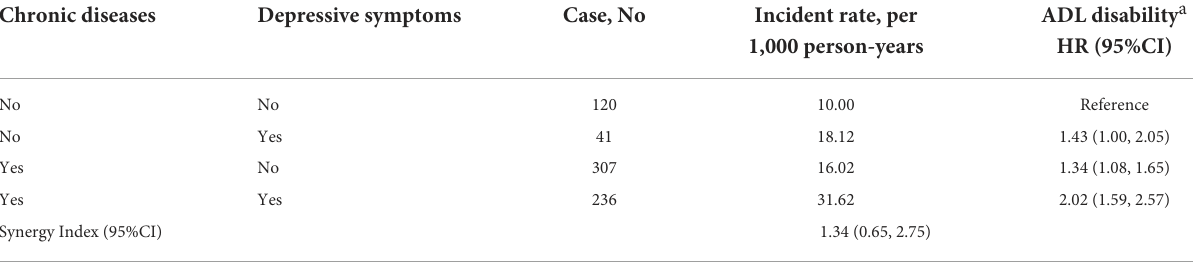
TABLE 3 The interaction between chronic diseases and depressive symptoms on incident ADL disability. Chronic